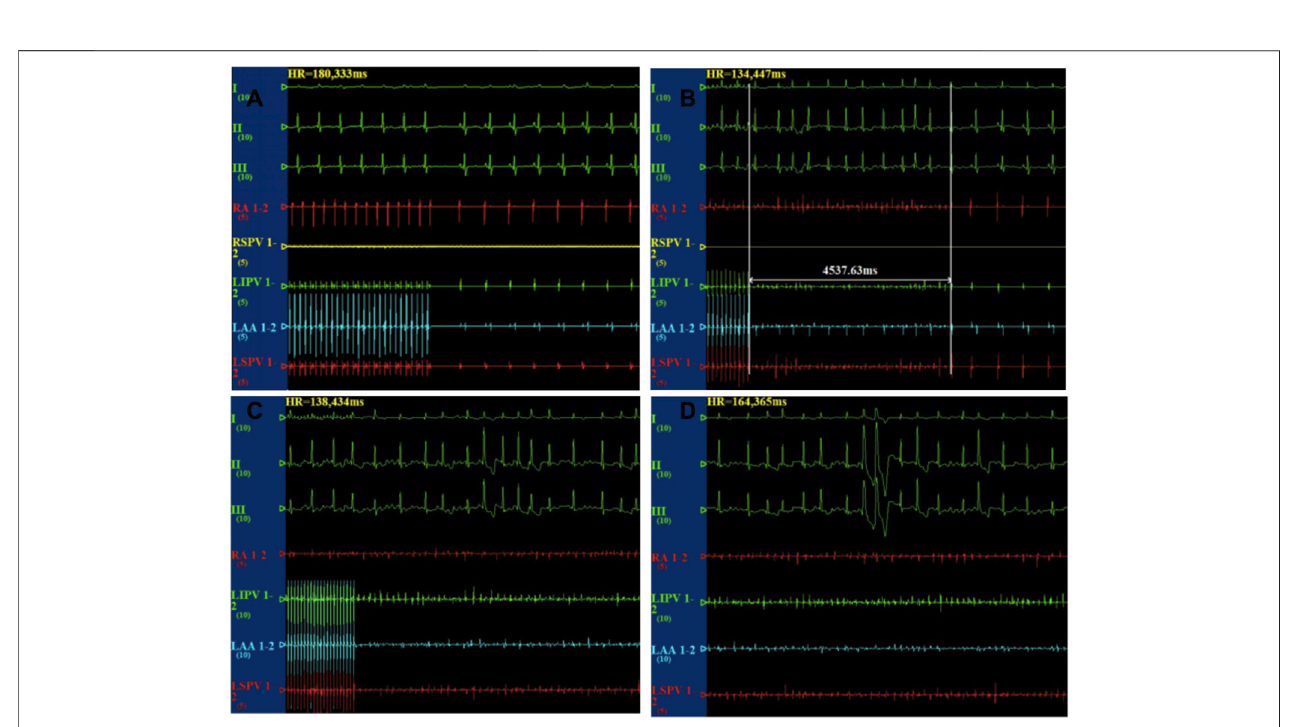
FIGURE4 | Representativepicture ofAF induction in the threegroups. Inthe control group, the burst pacing didn ’ t induce AF (A) . Inthe TRAM-34group, after 6 h pacing, the burst pacing didn ’ t induce AF (B) . In the RAP group, after 6 h pacing, the burst pacing induced AF last for 21.3 s (C,D) .